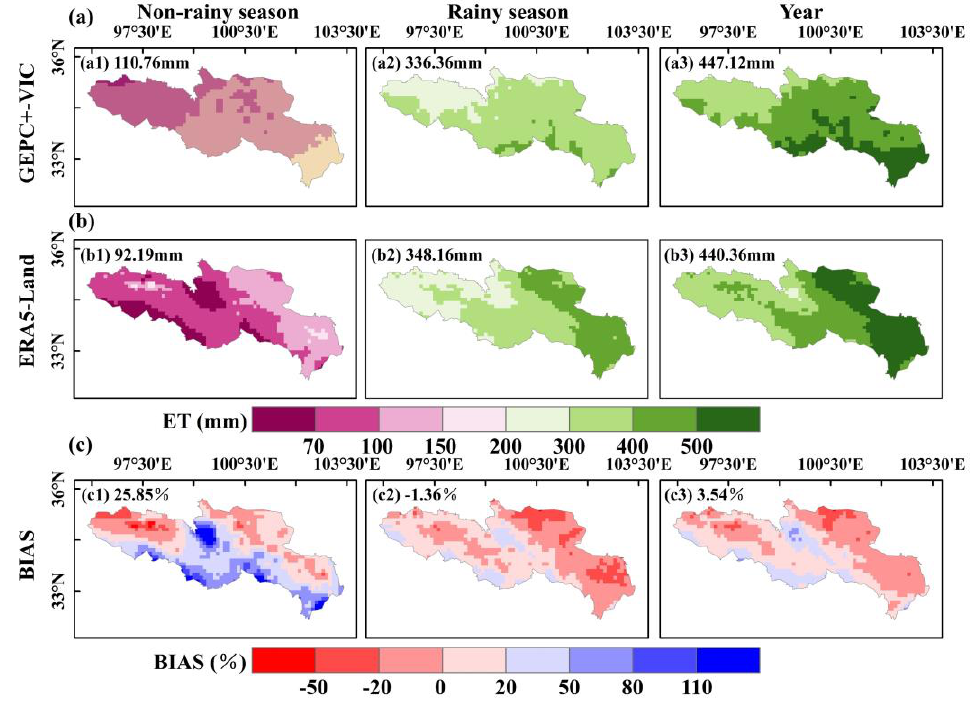
Figure 10. Comparison between GEPC+ simulated evapotranspiration and ERA5 Land evapotranspiration products. This study is divided into three periods: the non-rainy season, the rainy season, and the year. Results of GEPC+-VIC simulation ( a ) and ERA5 Land ( b ) and their relative deviation ( c ).